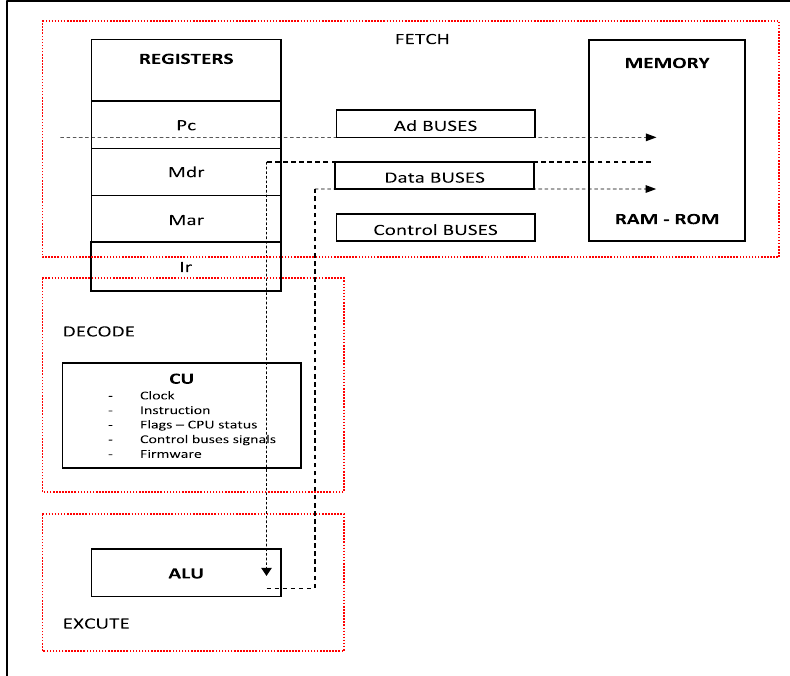
Fig. 3 The FDE cycle, the fundamental activity of the CPU. Once a string of code is received, the CPU re-writes that string